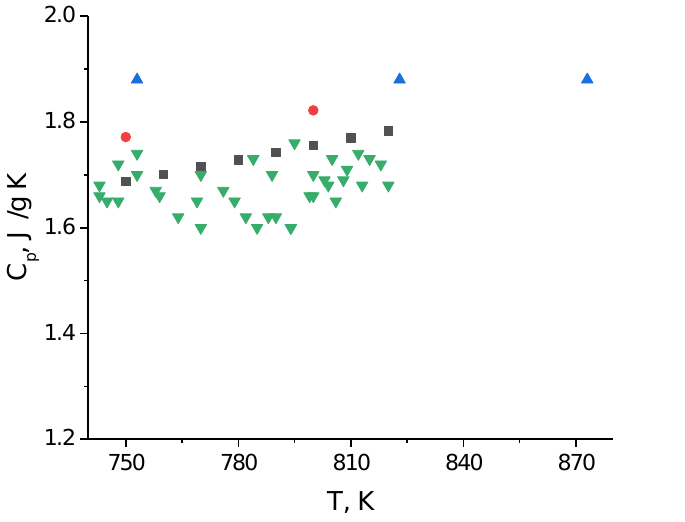
Figure 6. Heat capacity data for FLiNaK: ■ — Khokhlov, ●— Janz, ▲ — An, ▼ — this work.